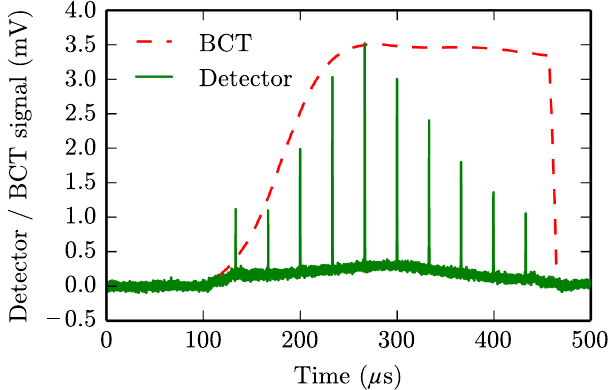
FIG. 11. Unamplified signal from a diamond detector channel sampling the H 0 particles for a given laser position ¼ 67 μ J; f ¼ 30 kHz), as function of time along ( E pulse pulse the 3 MeV H − beam pulse. This is compared to the beam current measured with a beam current transformer (BCT) downstream the laser